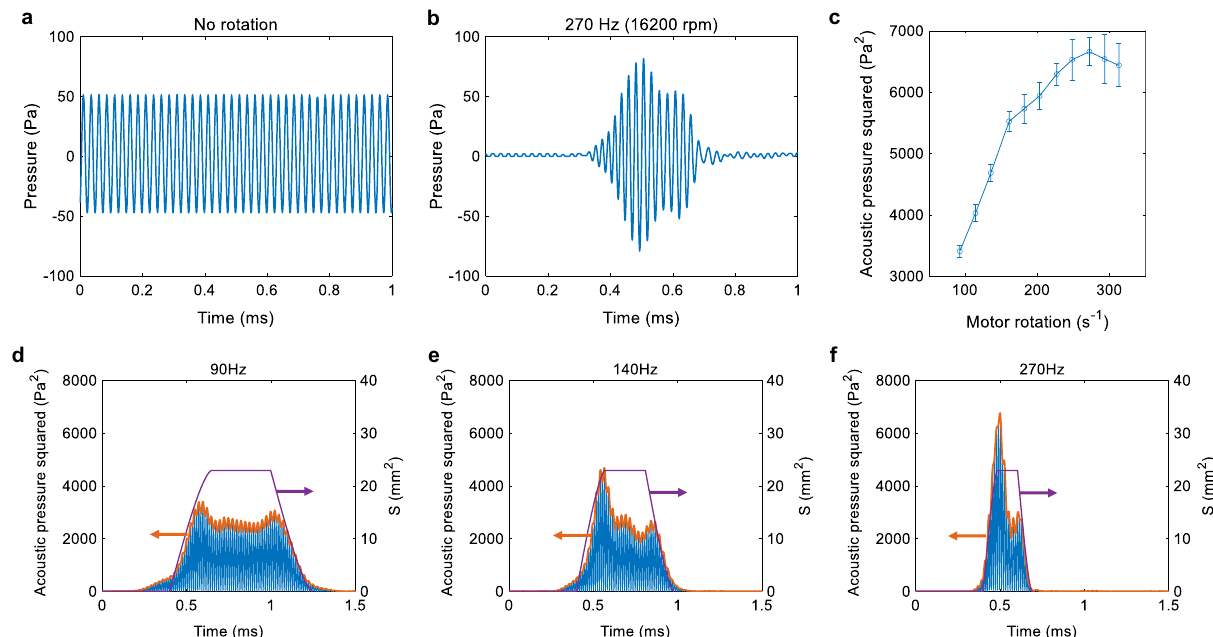
Figure 5. ( a ) Acoustic pressure when the shutter is fixed open with no rotation. ( b ) Acoustic pressure when the shutter is rotated at 270 Hz (16200 rpm). The result is processed by time-synchronous averaging for a measured sequence of 90 pulses. ( c ) Squared peak amplitude of the acoustic pressure as a function of motor rotation speed. Each value is obtained by time-synchronous averaging of 90 pulses of acoustic pressure. Error bars indicate the standard deviation. ( d–f ) Squared acoustic pressure (left axis) and the cavity opening area (right axis) for different rotation speeds of ( d ) 90 Hz, ( e ) 140 Hz and ( f ) 270